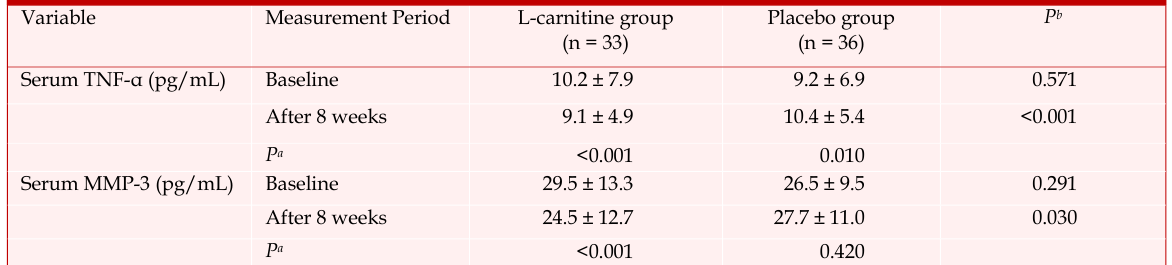
Comparison of biochemical variables in treatment groups before and after intervention